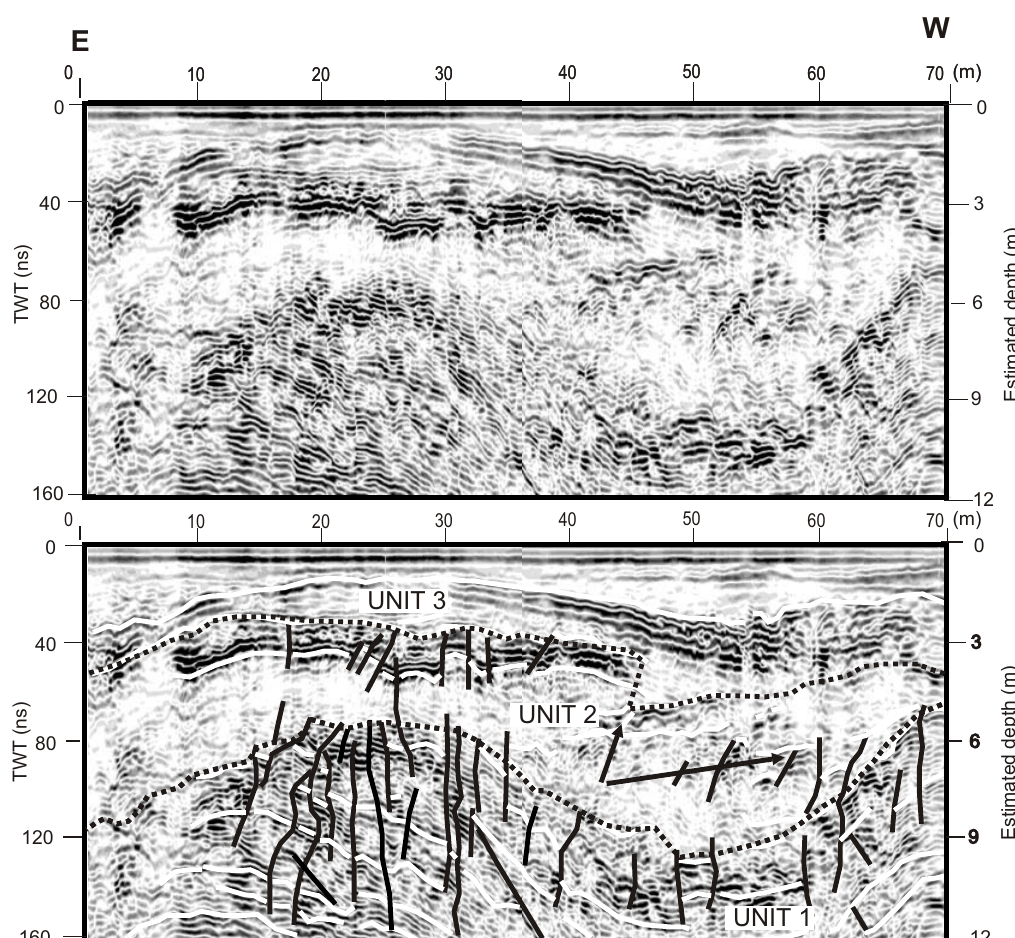
Fig. 8 – Non-annotated (upper) and interpreted (lower) GPR sections from theAtalaia Beach, showing a strongly deformed horizon at the base, forming two anticlines with an associated syncline (unit 1). The anticline apex shows numerous faults and fractures (indicated by the black vertical to inclined lines). Some of these continue upward into unit 2, but do not affect the youngest strata of unit 3. In particular the parallel reflections over the anticline to the left is strongly disrupted by normal and reverse faults. The white continuous lines indicate pronounced beds. The white dotted lines show the interpreted discontinuity surfaces that mark unit boundaries. The arrows point to places where beds on unit 2 could have been strongly disrupted by faults. See text for further